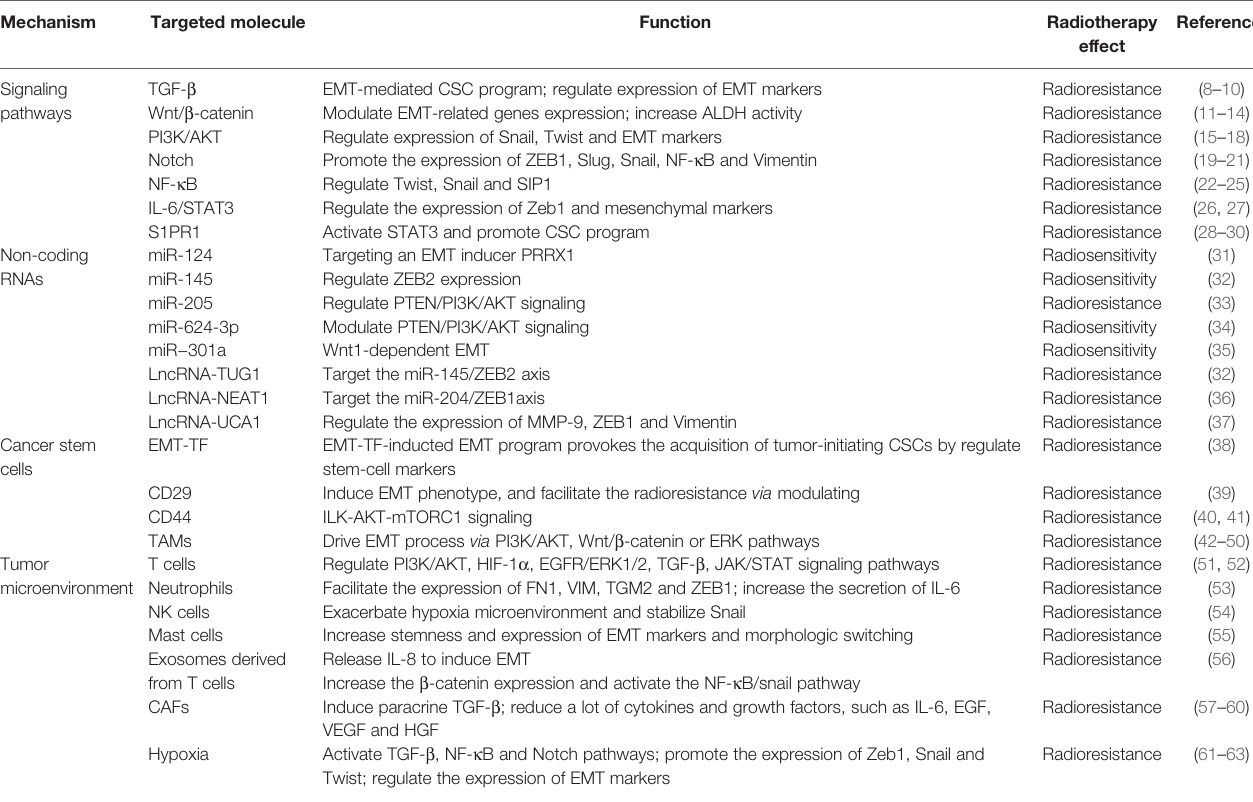
TABLE 1 | EMT-mediated mechanisms in